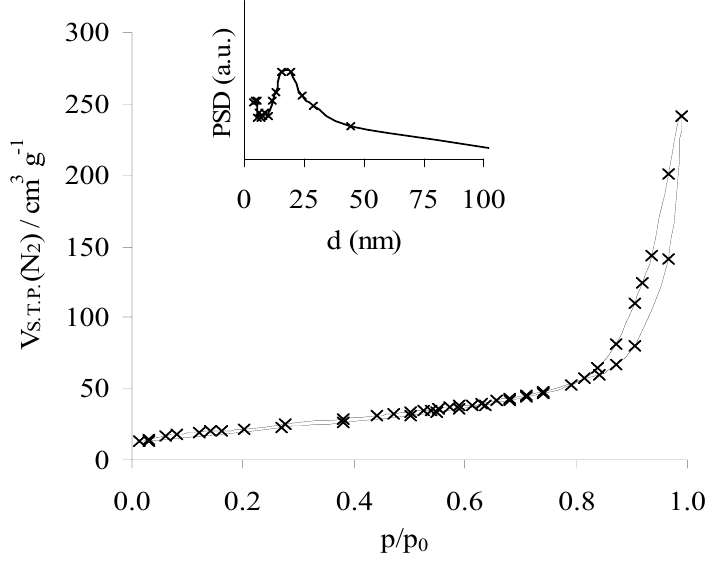
Figure 3. CeNR nitrogen adsorption-desorption isotherm (77 K) and (inset) pore-size distribution curve calculated for the desorption branch, using the Barrett-Joiner- Halenda